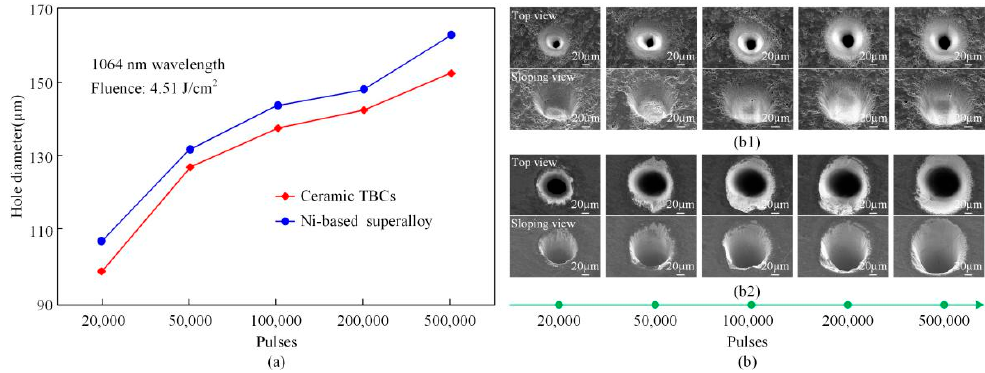
Figure 6. Holes diameters and SEM images in ceramic TBCs and Ni-based superalloy ( a ): Hole diameter ( b ): SEM image of holes ( b1 ): Ceramic TBCs ( b2 ): Ni-based superalloy.